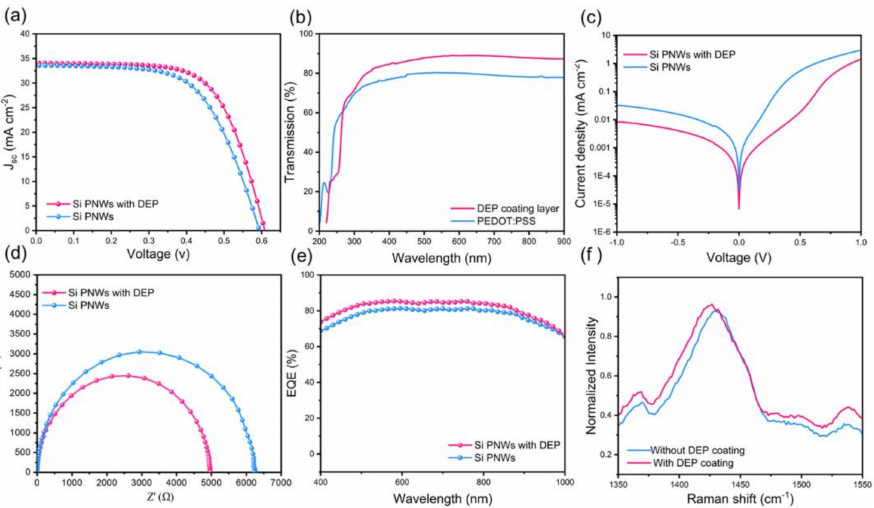
Figure 4. The devices coated with and without DEP: ( a ) J–V curves. ( b ) Reflectance. ( c ) Dark J-V ¯ R (%) of devices with DEP and without DEP coating. Table 2. Photoelectric property parameters and Texture Structure